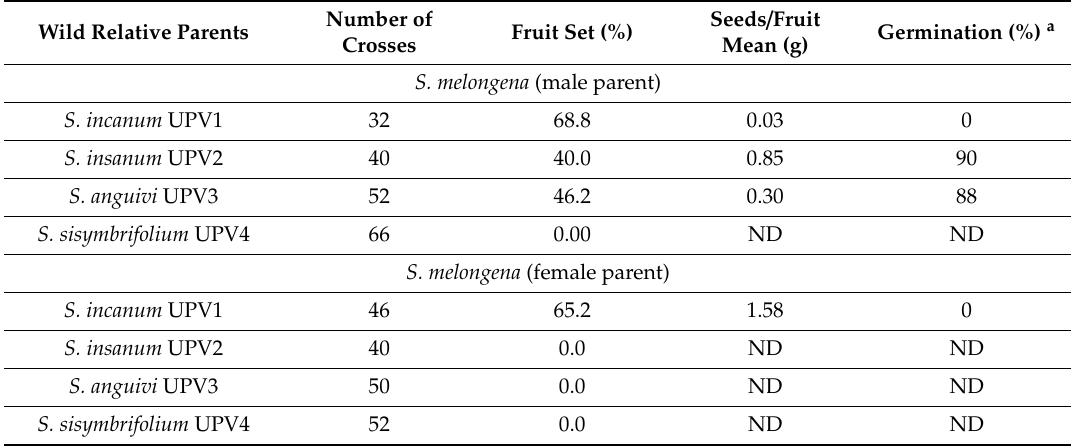
Table 1. Fruit set, seeds per fruit, and germination in interspecific hybridizations between Solanum melongena EG203 and wild eggplant